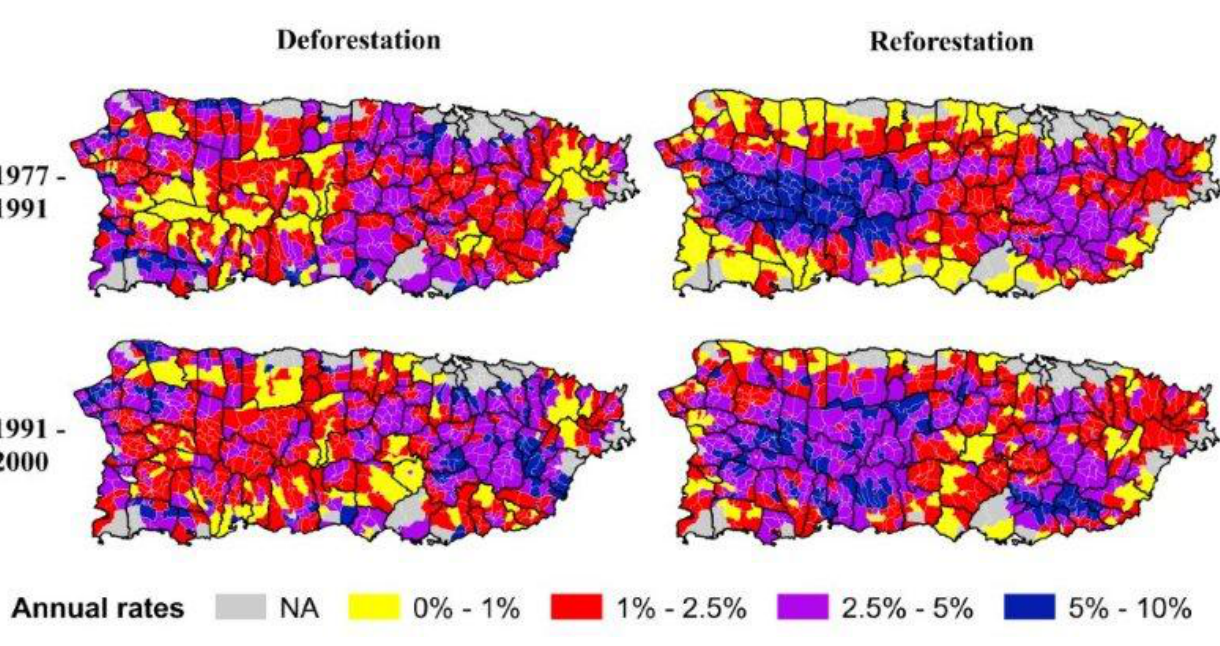
Fig. 2. Barrio (submunicipality) scale reforestation and deforestation rates calculated for 1977-1991 and 1991-2000 time intervals. Barrio boundaries are shown in white and municipio boundaries in